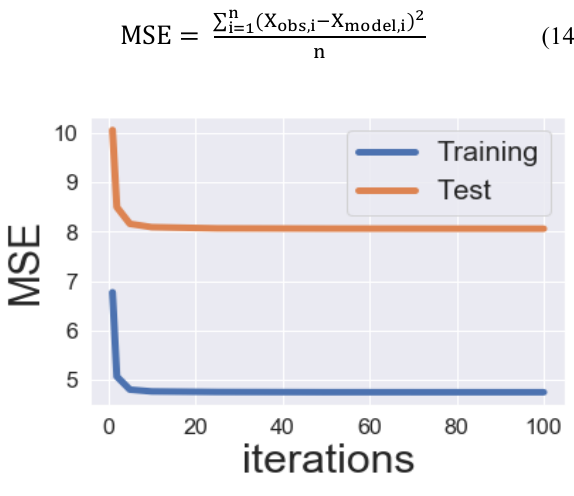
Figure 3. MSE Evaluation Graph for ALS algorithm